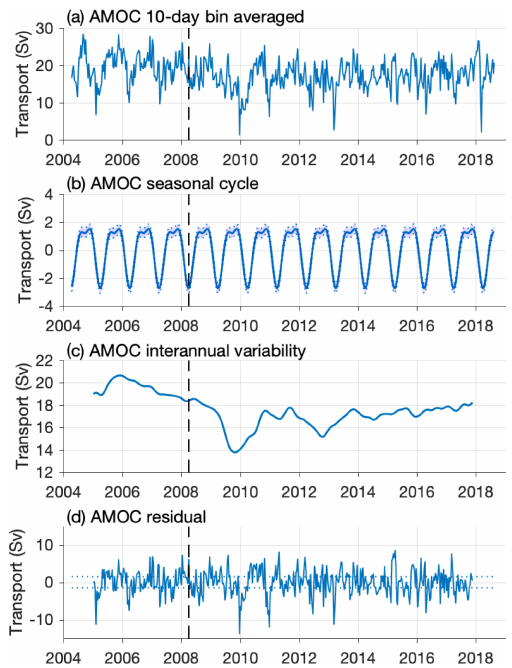
Figure 3. The total AMOC at 10-day resolution (a) can be decom- posed into a seasonal cycle (b) , interannual variability (c) and a residual (d) . The interannual component is obtained by filtering the data with a 540-day low-pass filter after removal of the mean sea- sonal cycle. In panel (b) , the dotted lines show the annual cycle ± 1 standard error, and the dotted lines in panel (d) are ± 1 . 5Sv the estimated error of 10-day binned data.